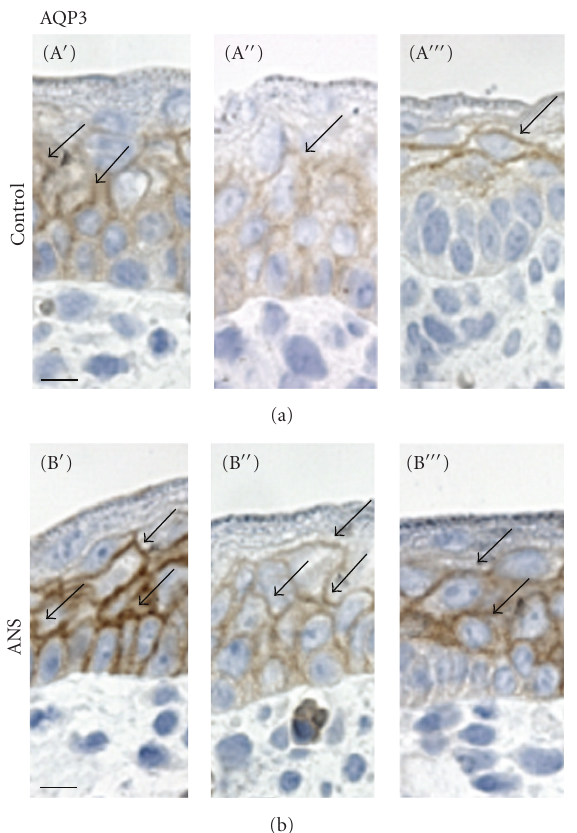
Figure 5: Representative images of immunoperoxidase localization of AQP3 in 2 μ m semithin para ffi n sections of skin from embryonic day 18 rat pups exposed to antenatal corticosteroids (ANSs; n = 3, B (cid:4) –B (cid:4)(cid:4)(cid:4) ) and from unexposed controls (Control; n = 3, A (cid:4) –A (cid:4)(cid:4)(cid:4) ). Anti-AQP3 labels the plasma membrane of epidermal keratinocytes. The AQP3 labeling intensity is higher in ANSs- exposed rat pups than in controls. Bar = 10 μ m.